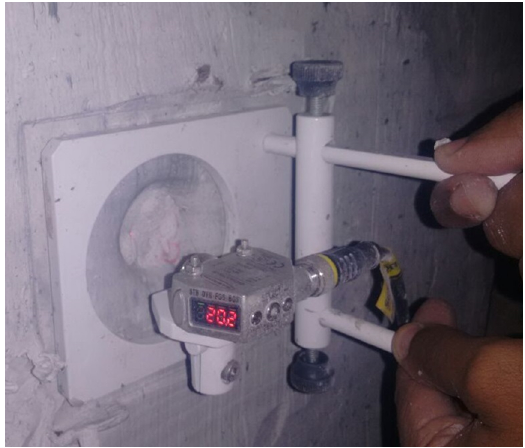
Figure 5. Measurement of the depth of indentation in the clay witness due to the remaining energy from the ballistic test 7.62 mm bullet impact against